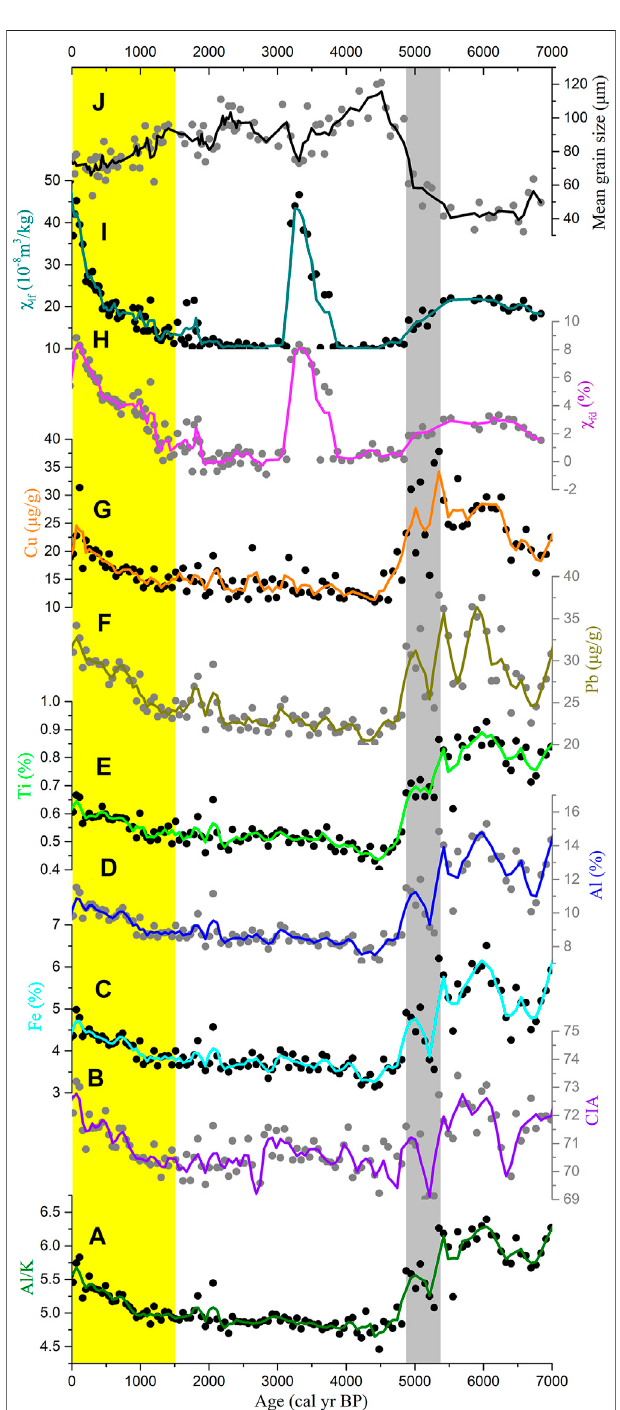
FIGURE 3 | Time series for multiple proxies measured in core GH6. The dotsindicatethe raw data,and the lines represent 3-point moving average.The grey bar indicates the recorded episode of abrupt climate change. The yellow bar represents the recent time period dominated by human activity.